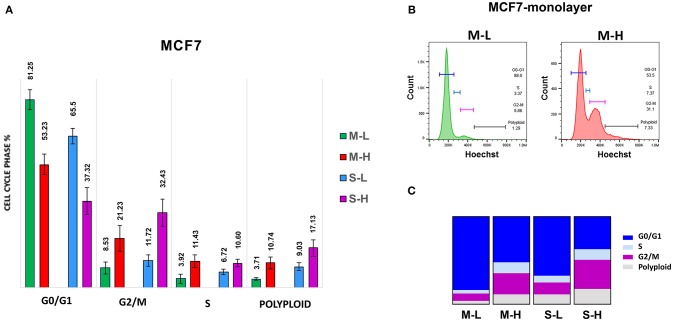
e-CSCs demonstrate increased cell cycle progression. Note that MCF7 cells with the highest flavin-content, have the highest rates of cell cycle progression and polyploidy. For example, M-H cells (from 2D-monolayers) and S-H cells (from 3D-spheroids) are hyper-proliferative and show the highest rates of cell cycle progression, as compared to the M-L and S-L sub-populations. Virtually identical results were also obtained when measuring the polyploidy of the various cell sub-populations; S-H had the highest numbers of polyploid cells. (A) Quantitation of cell cycle progression is shown as bar graphs, with the mean ± SD. (B) Representative traces from flow-cytometry for M-L and M-H sub-populations. (C) Condensed representation of (A). See also Table 1 for comparison.